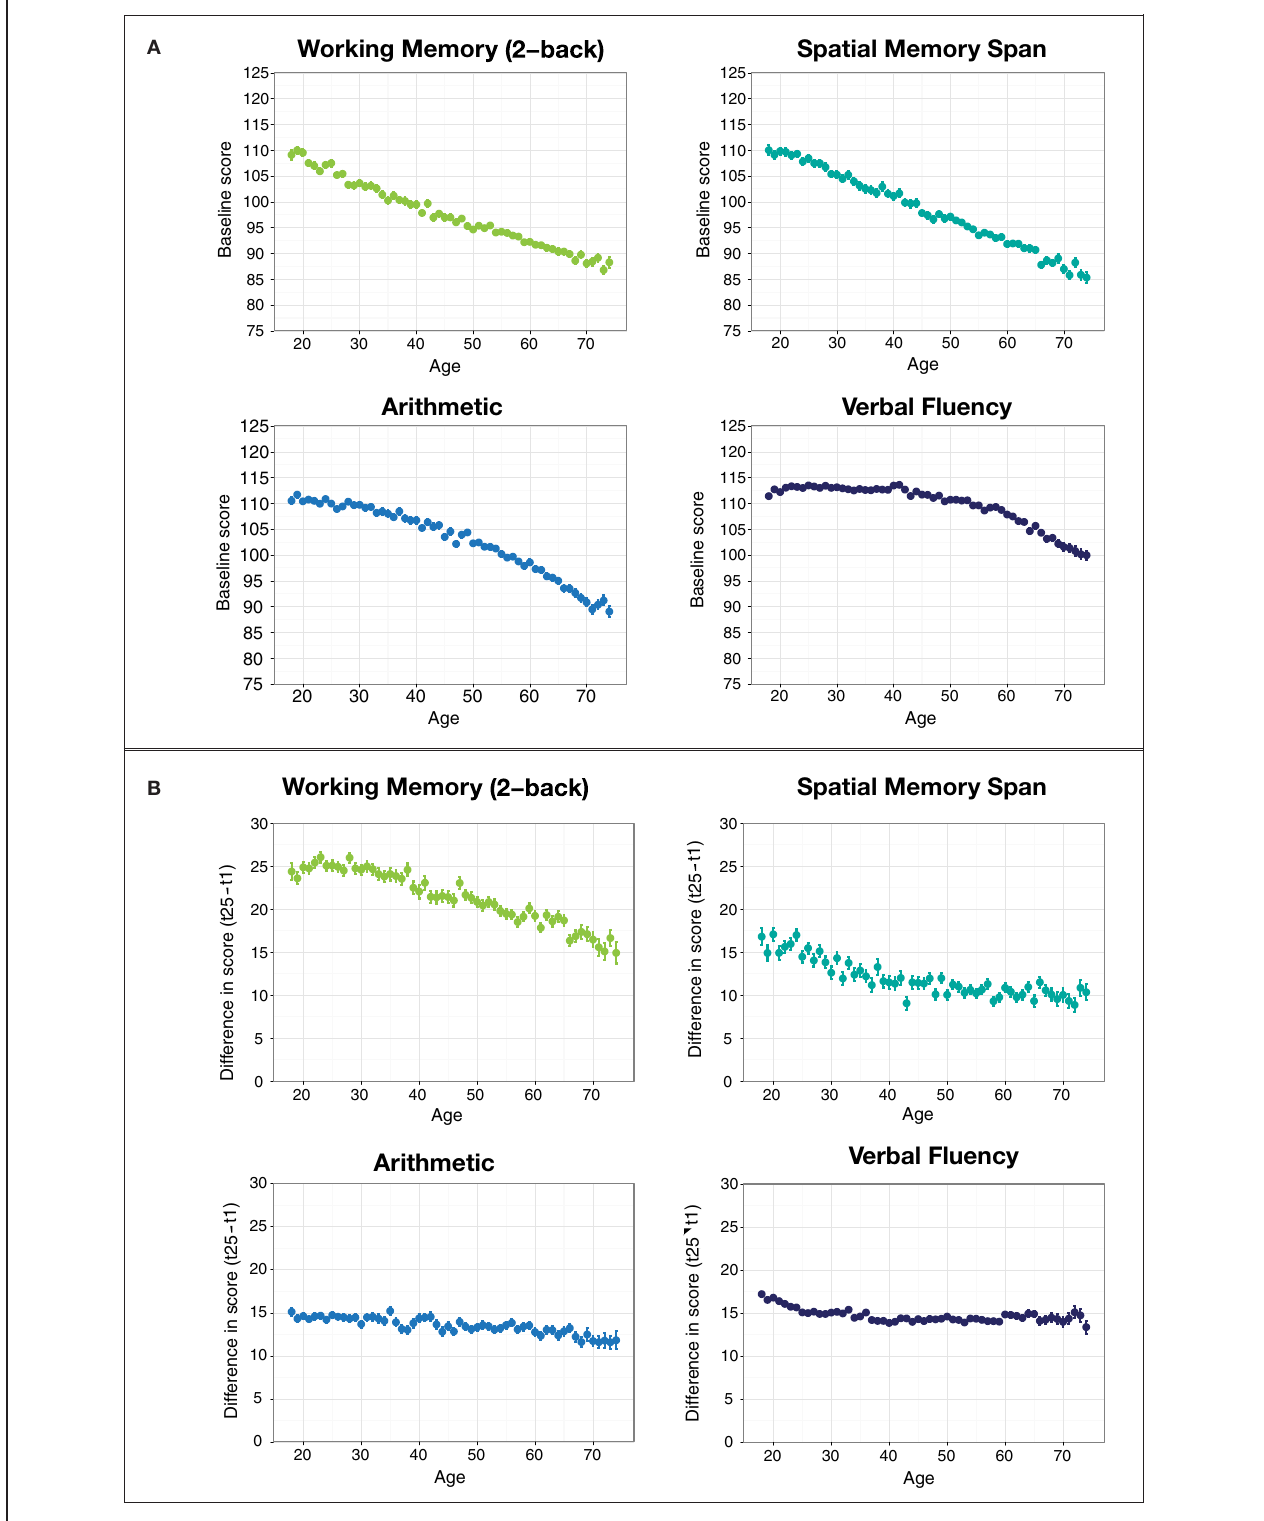
FIGURE 4 | (A) Mean game score by age at baseline. (B) Difference between 25th and 1st game score by age for each game. Error bars represent standard errors of the mean.